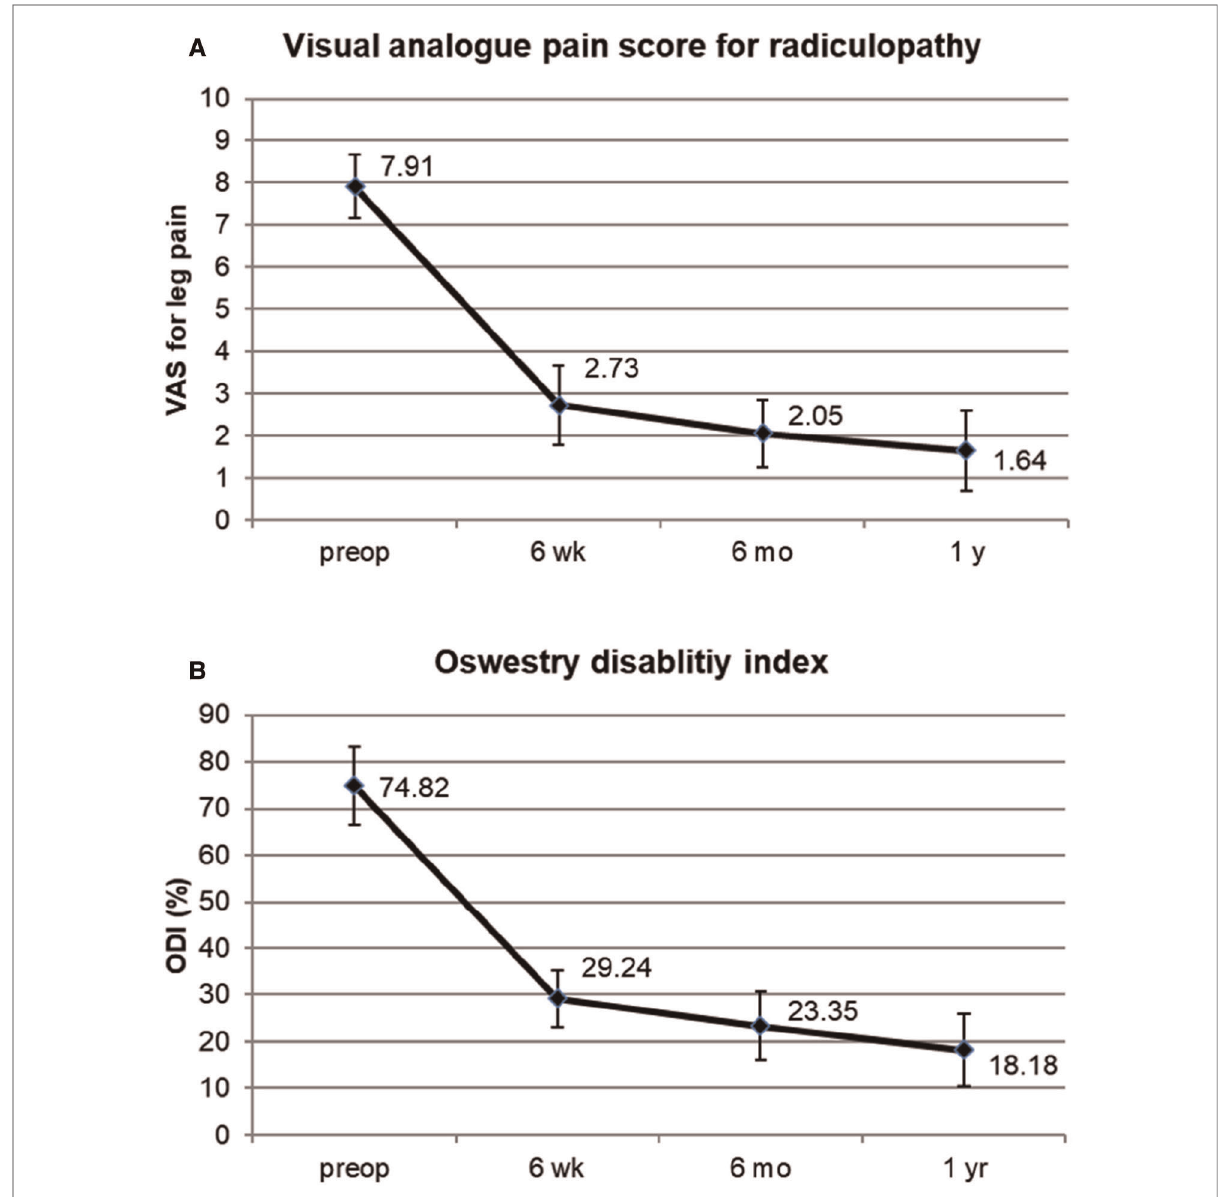
FIGURE 5 Clinical outcomes. (A) Visual analog pain score for radicular leg pain preoperatively and at 6 weeks, 6 months, and 1 year after surgery. (B) Oswestry disability index scores preoperatively and at 6 weeks, 6 months, and 1 year after